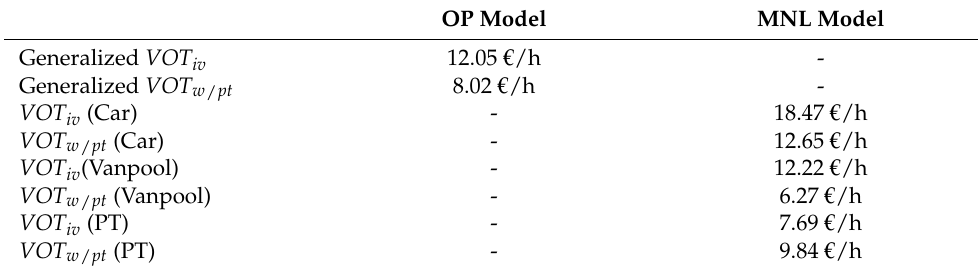
Table 5. Summary table of VOT obtained from OP and MNL